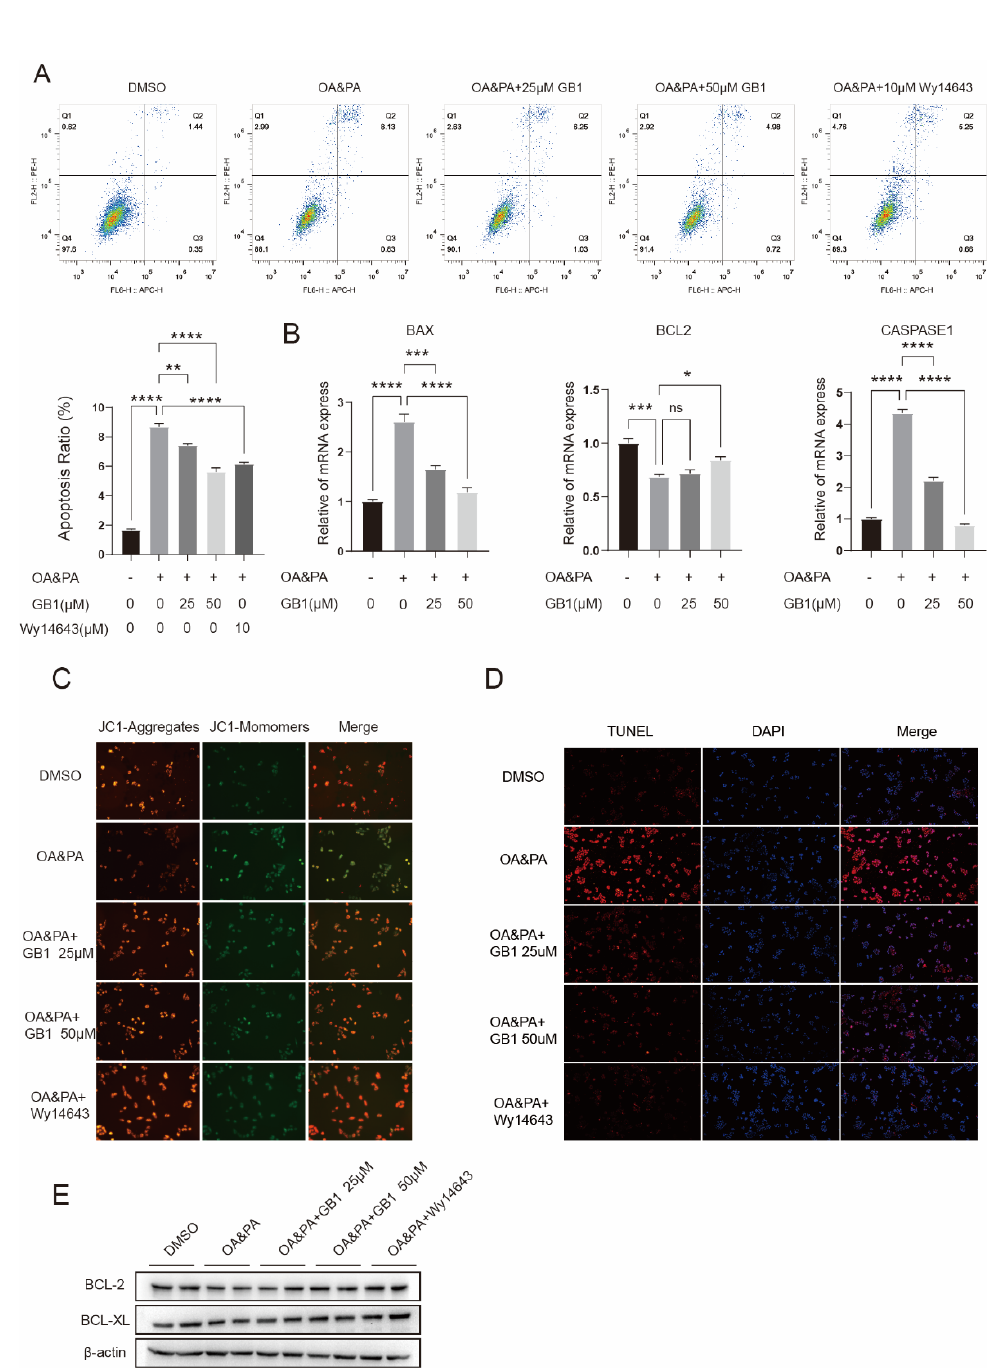
Figure 4. GB1 decreases the cell apoptosis induced by OA&PA. ( A ) Flow cytometry was performed to analyze cell apoptosis after treatment with GB1. ( B ) GB1 inhibited the expression of apoptosis-related genes. ( C ) Representative images for MMP after GB1 treatment (200×). ( D ) Representative images for TUNEL-labeled cells that underwent apoptosis (200×). ( E ) GB1 treatment elevated the expression of anti-apoptotic proteins. All data were presented as mean ± SEM of three independent experiments. *, p < 0.05, **, p < 0.01, ***, p < 0.001, ****, p < 0.001; ns, not significant.